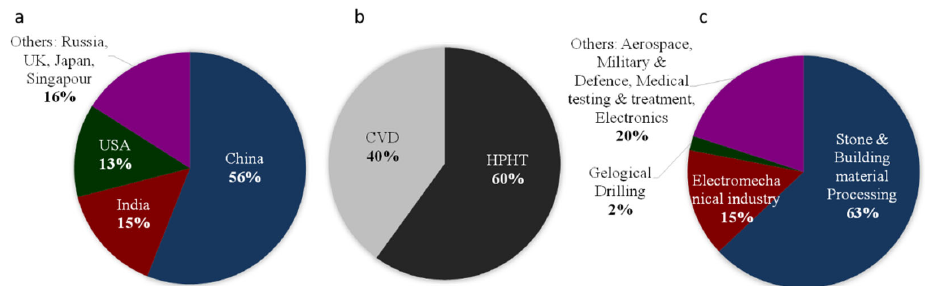
Figure 6. Synthetic diamond production in 2019 represents ~18 billion carats [64,65]. ( a ) By country, China accounts for more than the half of the worldwide production. ( b ) By technique, similar amount is produced using HPHT and CVD. It is of note that China represents 98% of the HPHT synthesis of diamonds. ( c ) By application, from usual tools (e.g., grit, abrasives and drilling) to new technology uses (e.g., in electronics, medicine). Note that synthetic diamond production for jewelry is negligible.